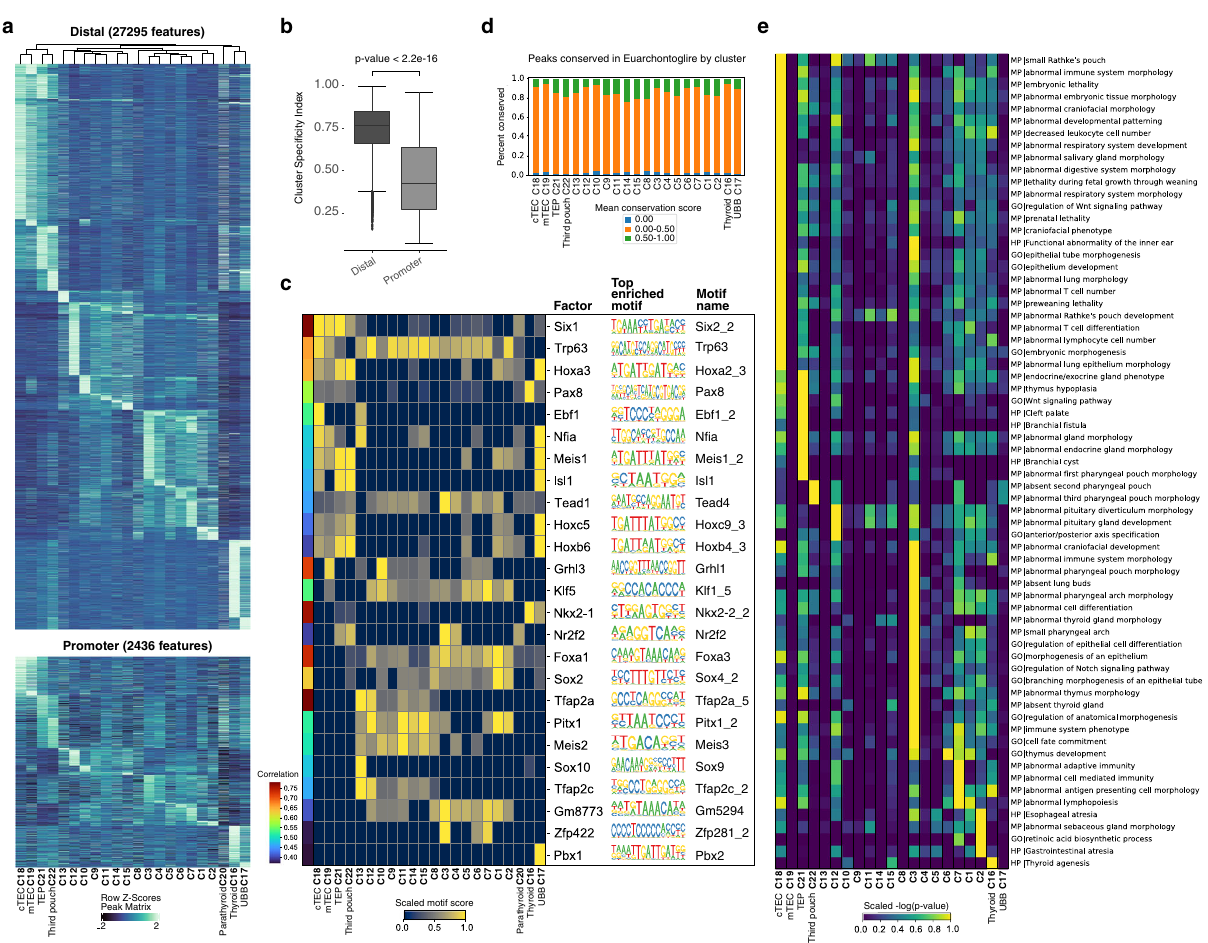
Fig. 3 Distal peaks lend cell-type uniqueness and reveal underlying cell-type-speci fi c pathways and phenotypes. a Heatmap of differential cluster- speci fi c peak accessibility (FDR ≤ 0.01, log2-fold change ≥ 0.5) parsed into distal ( n = 27,295 peaks) and promoter ( n = 2436 peaks) with clusters ordered by unsupervised hierarchical clustering on the distal peaks and row z-scored. TEP, thymic epithelial progenitor. b Boxplot showing cluster speci fi city of differentially accessible distal ( n = 27,295) and promoter proximal ( n = 2436) peaks measured by cluster-speci fi city index on scaled, log2- transformed cluster averaged peak accessibility. Center line denotes the median; box limits denote upper and lower quartiles; top and bottom whiskers denote regions upto 1.5 times the inter-quartile range above the upper and below the lower quartiles, respectively; tailing points denote outliers. P -value is from a two-sided Wilcoxon test with continuity correction and without adjustment. c Heatmap of top 10% of distal regulators per cluster determined by a motif score (average ChromVar motif z-score per cluster – minimum cluster average motif z-score) on a set of 55,840 differentially accessible distal peaks (FDR ≤ 0.1, log2-fold change ≥ 0.5) with color bar displaying correlation of the ChromVar motif z-scores with the integrated gene expression (correlation cutoff > 0.35). d Percent of distal differentially accessible peaks between clusters (FDR ≤ 0.01, log2-fold change ≥ 0.5) having an average phastCon conservation score within the Euarchontoglires clade = 0.00, >0.00 and ≤ 0.50, and >0.50 split by cluster. Cluster 20 has no peaks meeting the differential accessibility cutoff. e Heatmap of row normalized − log10 corrected p -values (Benjamini – Hochberg) from the binomial test on a curated list of GREAT terms enriched in distal, differentially accessible peaks (FDR ≤ 0.01, log2-fold change ≥ 0.5) with an average phastCon conservation score within the Euarchontoglires clade of